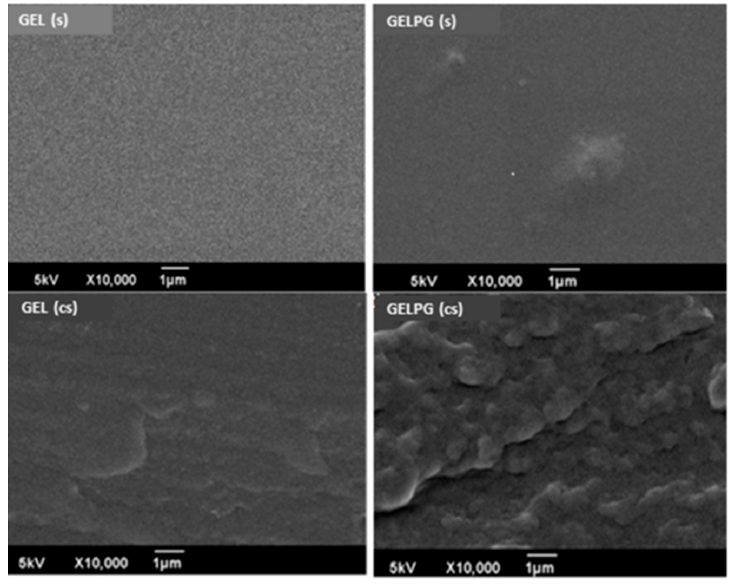
Figure 3. Photomicrographs of GEL and GELPG membranes. (s) are the surface images, and (cs) are the cross-section images.